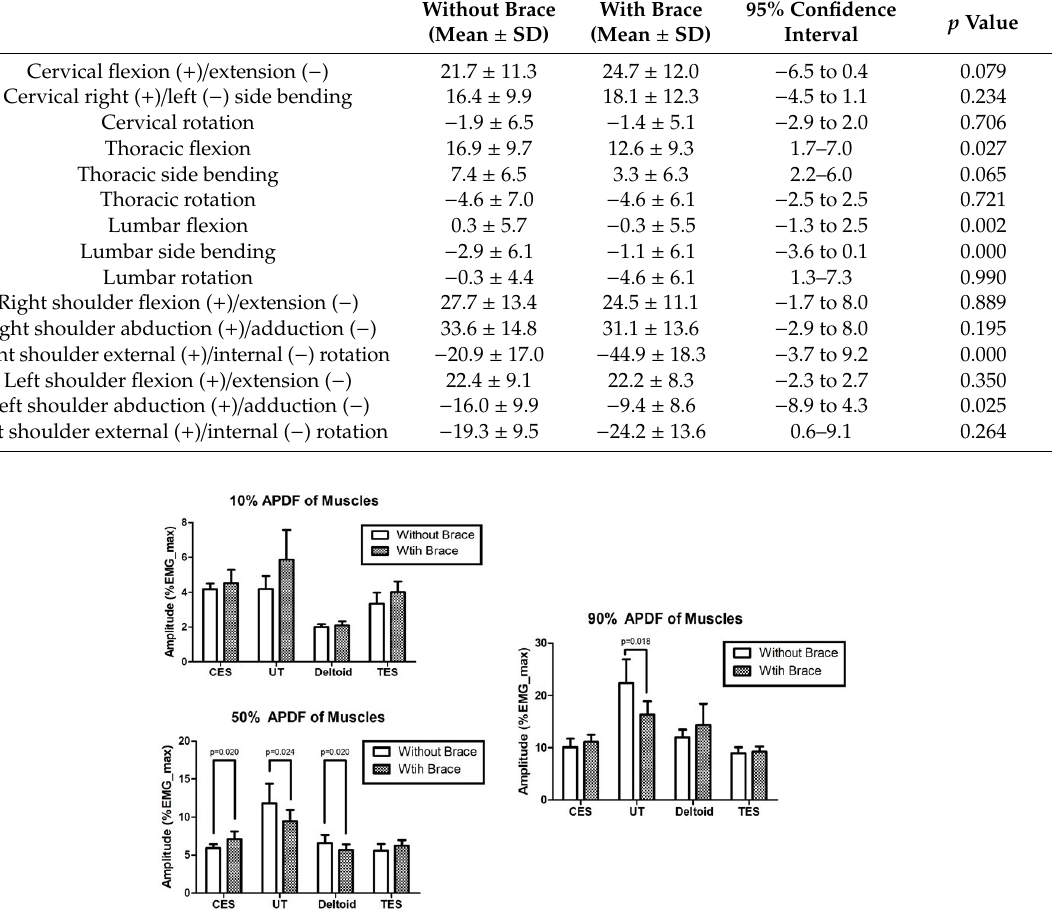
Figure 3. Muscle activity levels with and without the 8-figure shoulder brace; EMG, Surface electromyography; CES, Cervical erector spinae; UT, Upper trapezius; TES, thoracic erector spinae; APDF, Amplitude probability distribution function.